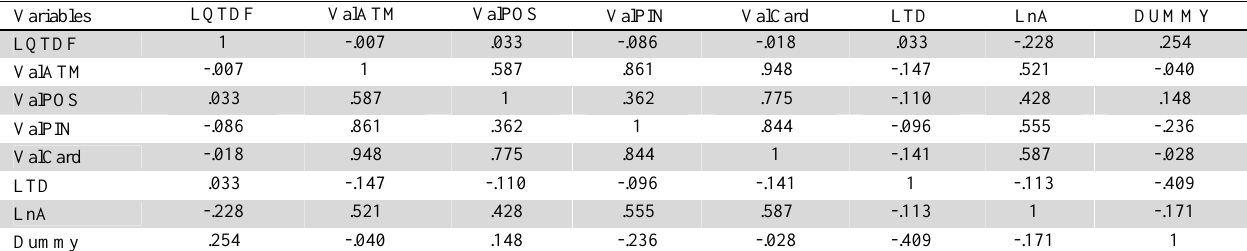
The relationship between the dependent and independent variables in the third model